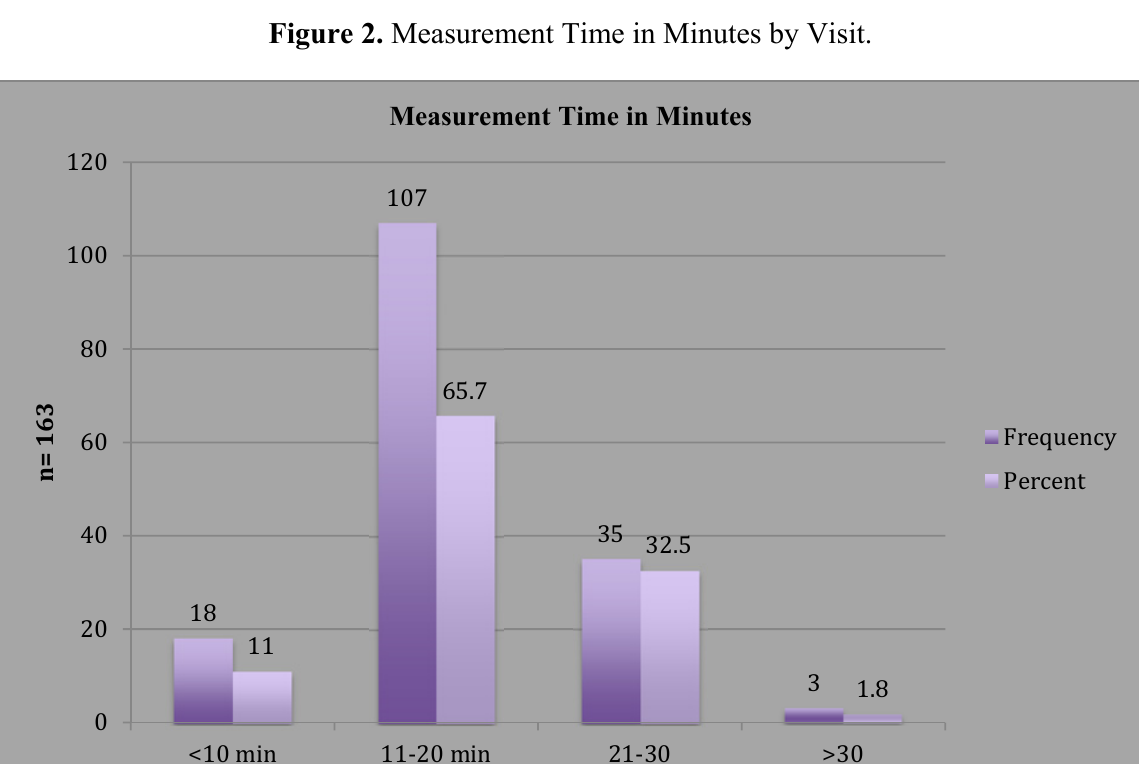
Figure 3. Measurement Time in